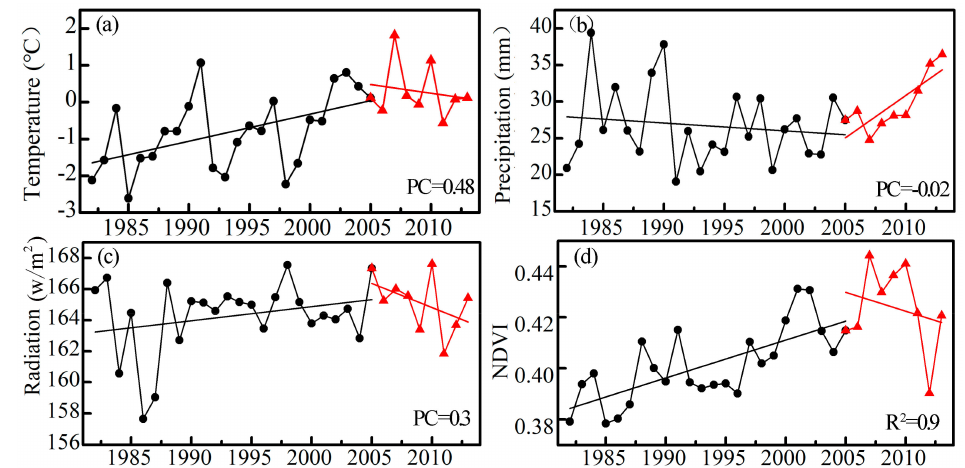
Figure 5. Climatic factors and NDVI variations in northeastern Russia from 1982–2013. ( a ) Temperature (T); ( b ) precipitation (P); ( c ) radiation (R); and ( d ) NDVI; the black line and the red line represent the changing trends before and after the temperature change. PC represents the partial correlation coefficient of each climatic factor with NDVI, excluding the other two meteorological variables, and R 2 represents the coefficient of determination between the NDVI and the meteorological factors. The relationship between NDVI and the